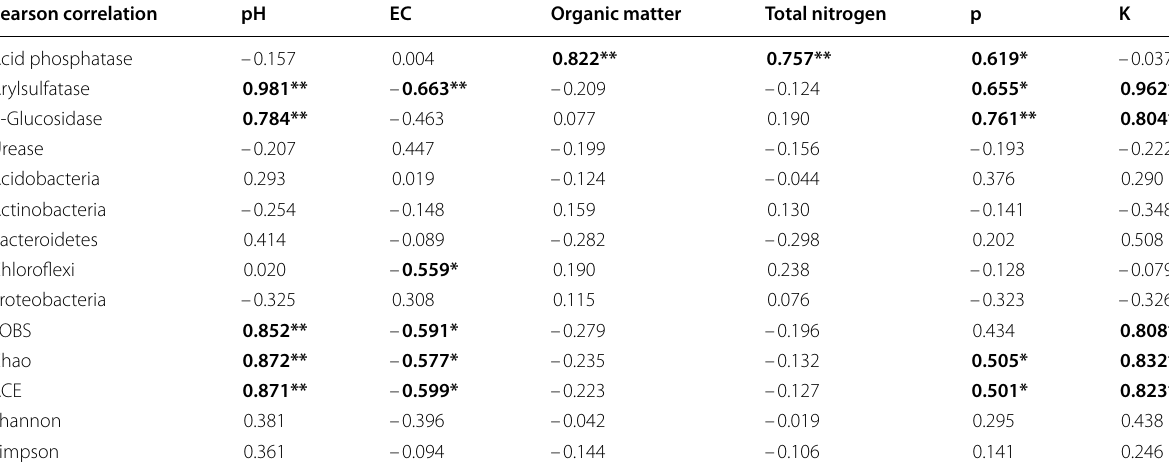
Significance is indicated by **p-value < 0.01, and *p-value < 0.05